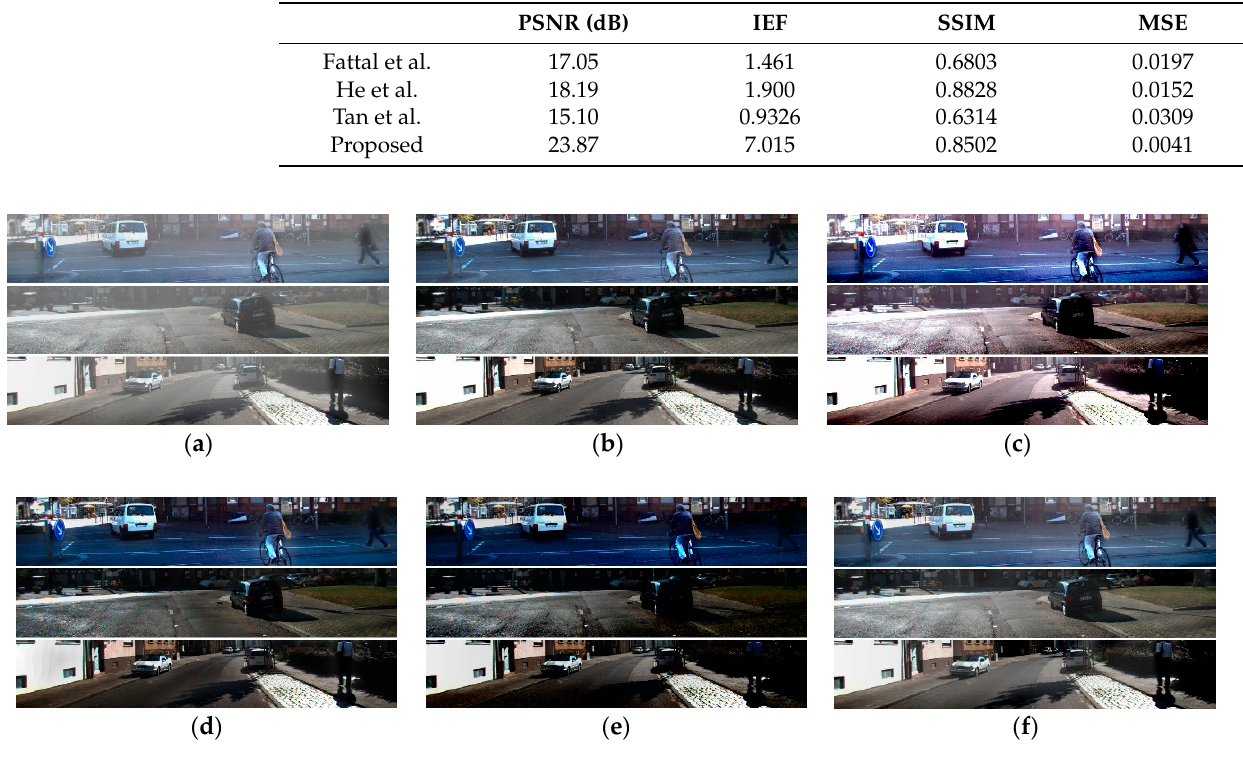
Figure 15. Dehazing result of various algorithms: ( a ) hazy image; ( b ) ground truth; ( c ) Fattal’s method; ( d ) He’s method; ( e ) Tan’s method; ( f ) proposed method. Table 4. Comparison result 1 using upper image from Figure 15.